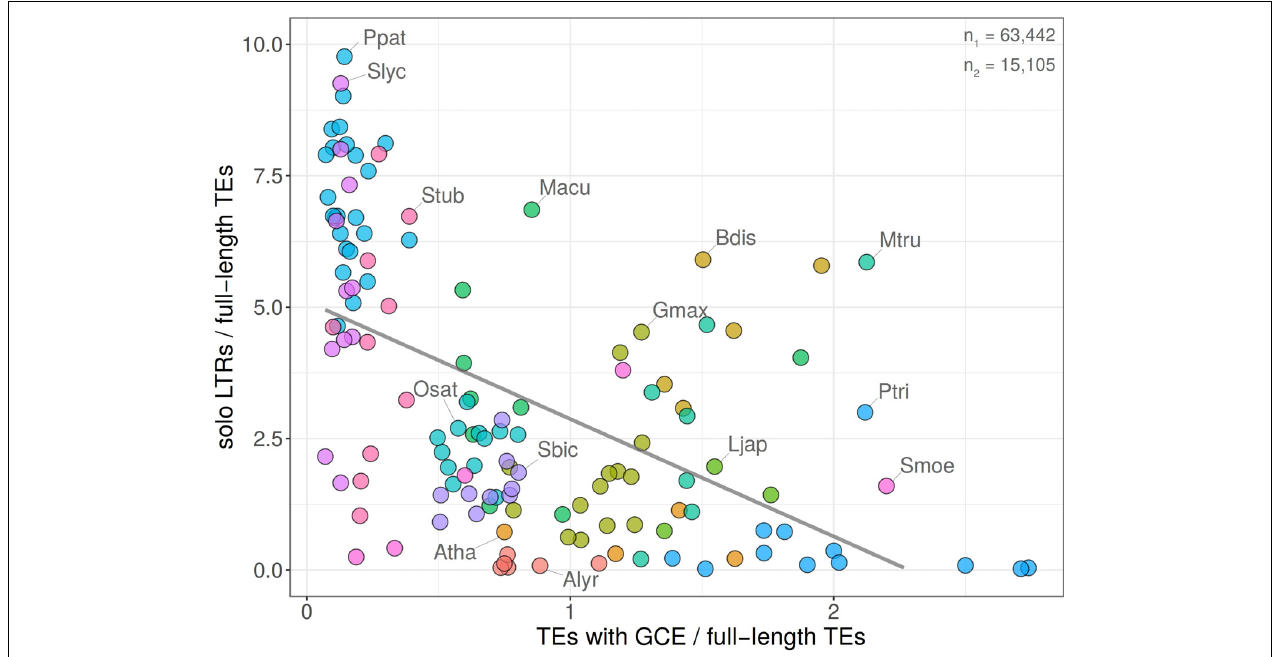
FIGURE 8 | Relationship between gene conversion and solo LTR formation. Dependence of gene conversion events (GCE) predicted by GENECONV plotted against the ratio of solo LTR/FL ( y = 5.11–2.23 x ; R 2 = 0.29; Pearson’s r = –0.5428 with p -value = 1.784e-11). Chromosomes with no records of GCE and/or solo LTRs were excluded. Total counts of solo LTRs and elements with GCE are indicated ( n 1 and n 2 , respectively). Each filled circle corresponds to one chromosome, plant species are labeled by different colors. The graph shows that chromosomes containing high proportions of gene converted element LTRs contain low proportions of solo